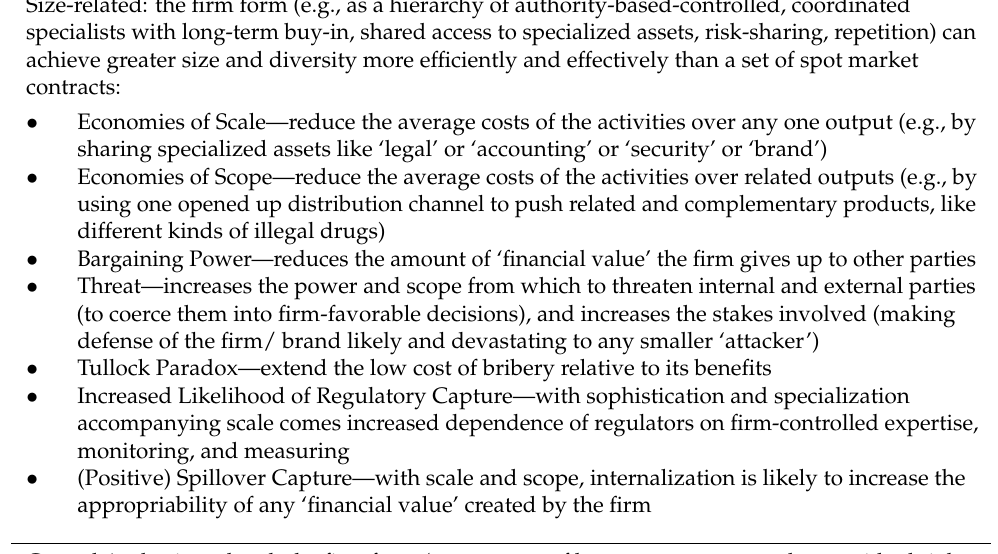
Table 2. Illustrative Advantages from the Firm Form in Doing ‘Bad’